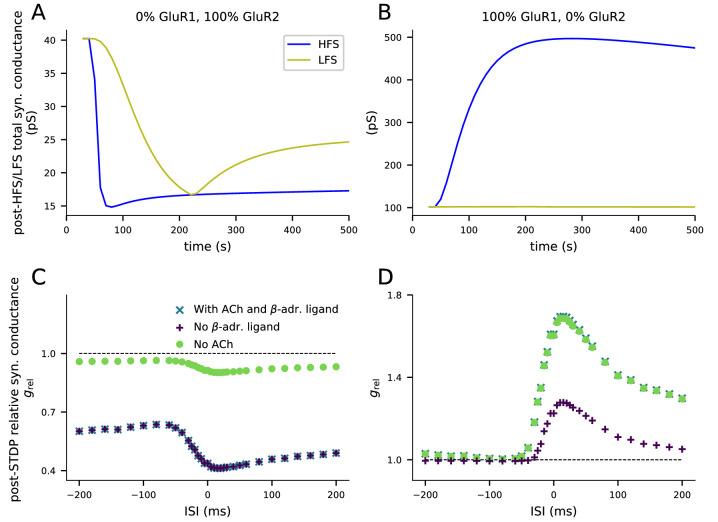
Both GluR1 and GluR2 are needed for bidirectional plasticity.(A) When GluR1 subunits are absent, 4xHFS induces LTD instead of LTP. (B) When GluR2 subunits are absent, LFS does not lead to changes in synaptic conductance. (C) When GluR1 subunits are absent, the paired-stimulus protocol induces acetylcholine-mediated LTD but not β-adrenergic ligand-mediated pairing interval-dependent LTP. (D) When GluR2 subunits are absent, the paired-stimulus protocol induces β-adrenergic ligand-mediated pairing interval-dependent LTP, but not acetylcholine-dependent LTD. (A–B) The y-axis shows the total synaptic conductance, and the x-axis shows the time. The 4xHFS stimulation lasts from 40 to 53 s, and the LFS stimulation from 40 to 220 s. See Figure 3 for details. (C–D) The y-axis shows the relative synaptic conductance, and the x-axis shows the inter-stimulus interval (ISI). See Figure 5 for details.